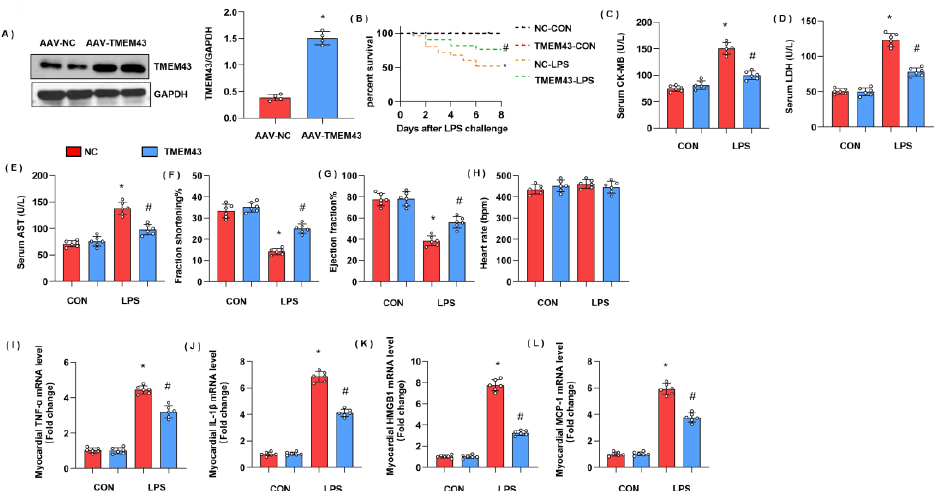
Figure 5. TMEM43 overexpression alleviates LPS-induced cardiac injury. ( A ) Protein level of TMEM43 in mouse hearts injected with AAV-TMEM43 ( n = 4). ( B ). Survival rate of mice in each group ( n = 25). ( C – E ) Serum CK-MB, LDH, and AST in each group ( n = 6). ( F – H ) Echocardiography result in each group ( n = 6). ( I – L ) mRNA level of pro-inflammatory factors in heart tissue under LPS challenge ( n = 6). * p < 0.05 vs. AAV-NC/CON group. # p < 0.05 vs. AAV-NC/LPS group.